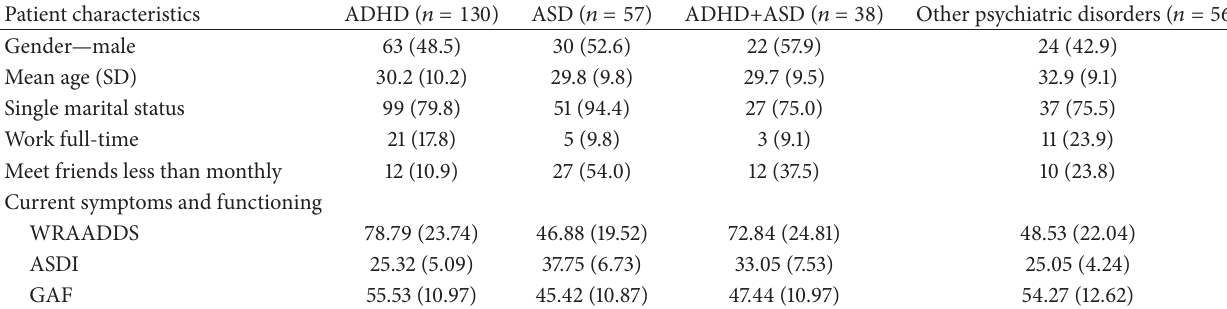
Table 1: Participant characteristics for each patient group.